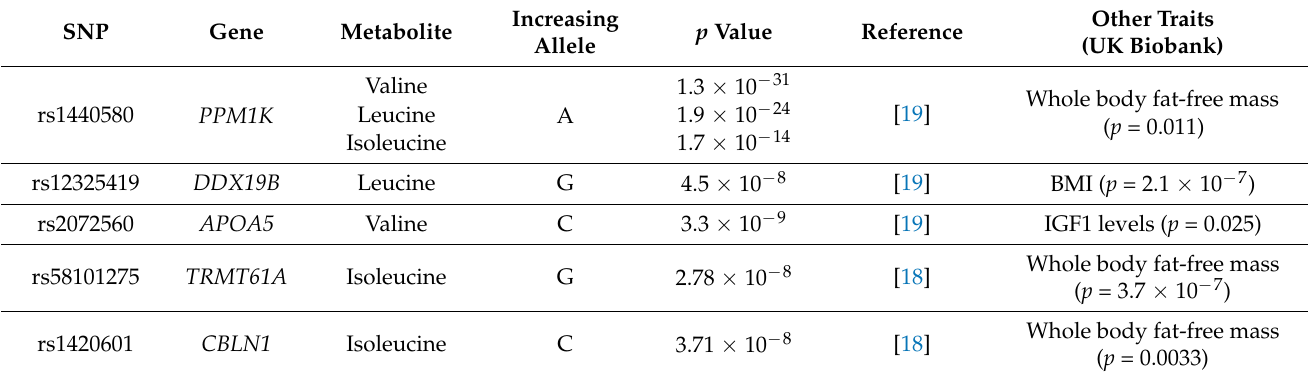
Table 1. SNPs associated with plasma BCAA levels (literature data).